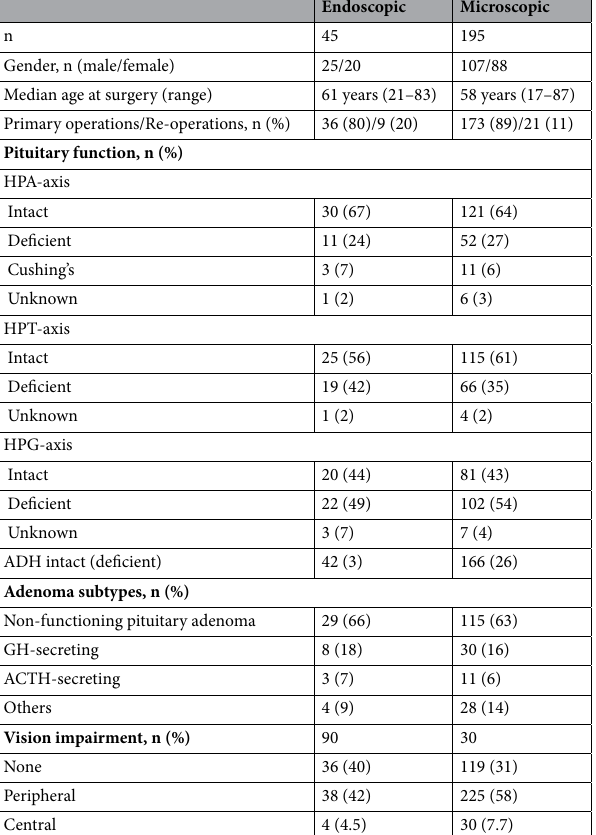
Table 1. Preoperative characteristics of patients with pituitary adenomas undergoing either endoscopic or microscopic surgery. HPA Hypothalamus–pituitary–adrenal, HPT Hypothalamus–pituitary–thyroid, HPG Hypothalamus-pituitary–gonadal, GH Growth hormone, ACTH Adrenocorticotropic